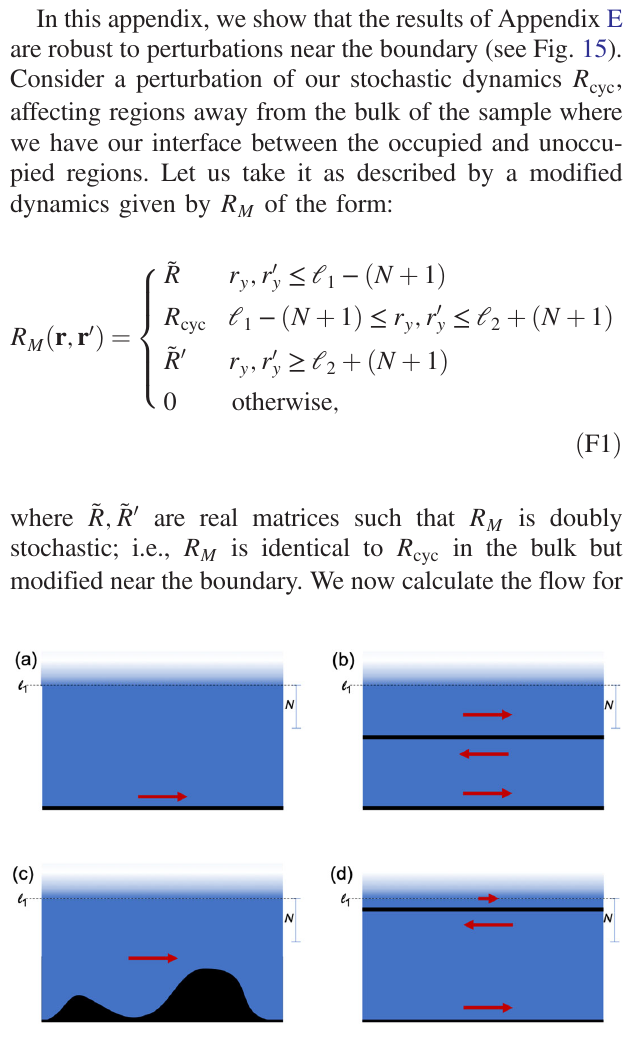
FIG. 15. An illustration of the stability of the flow. When the initial state has uniform density below the line l 1 , our N cycle flow is only sensitive to perturbations occurring in the region above l 1 − N . For large N , the initial density configurations (a), (b), and (c) will have the same N cycle transport despite having drastic differences in R matrices (e.g., by introducing new edges in the system drawn in black above). On the other hand, panel (d) will have a reduced N cycle flow, since, in contrast with panel (b), the partially filled area on the upper part of the new edge will not be enough to cancel the flow below